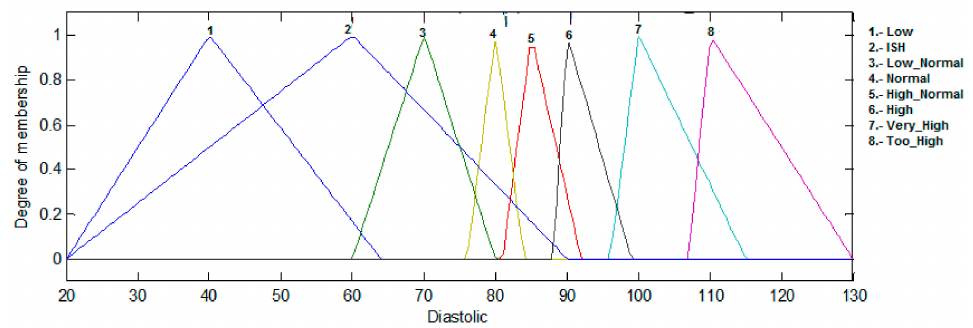
Figure 5. Diastolic input for the fuzzy logic classifier